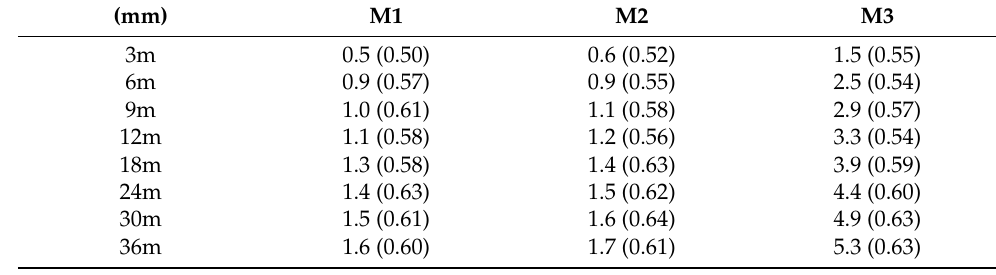
Table 9. Depth (mm) of natural carbonation and standard deviation of mortar mixtures exposed in Xanthi.